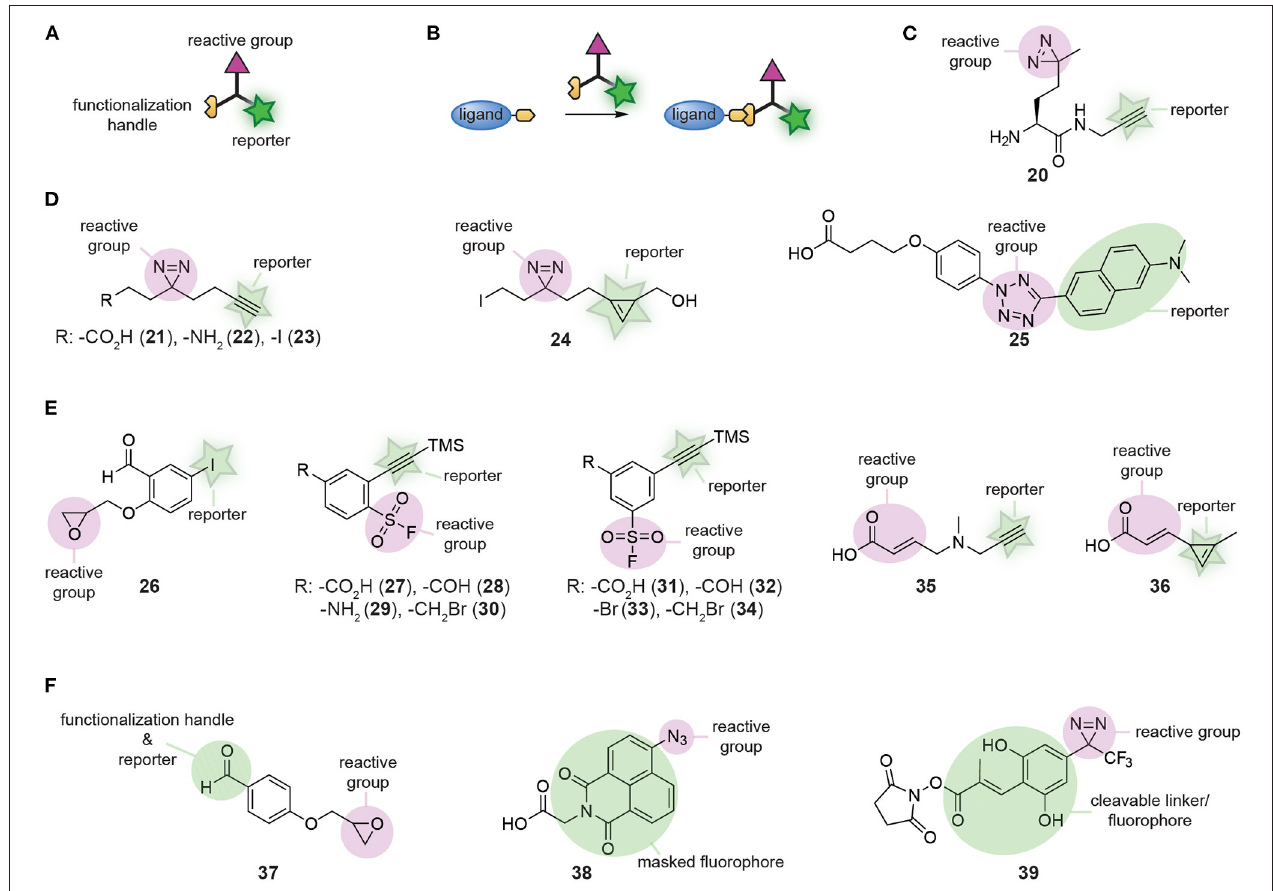
FIGURE 8 | (A) Schematic representation of a trifunctional reagent. (B) Schematic representation of the synthesis of a probe using a trifunctional reagent. (C) Structures of a first-generation trifunctional reagent. (D) Examples of minimalistic trifunctional photocrosslinker reagents. (E) Examples of minimalistic trifunctional chemical crosslinking reagents. (F) Examples of reactive groups that contain dual-purpose elements.